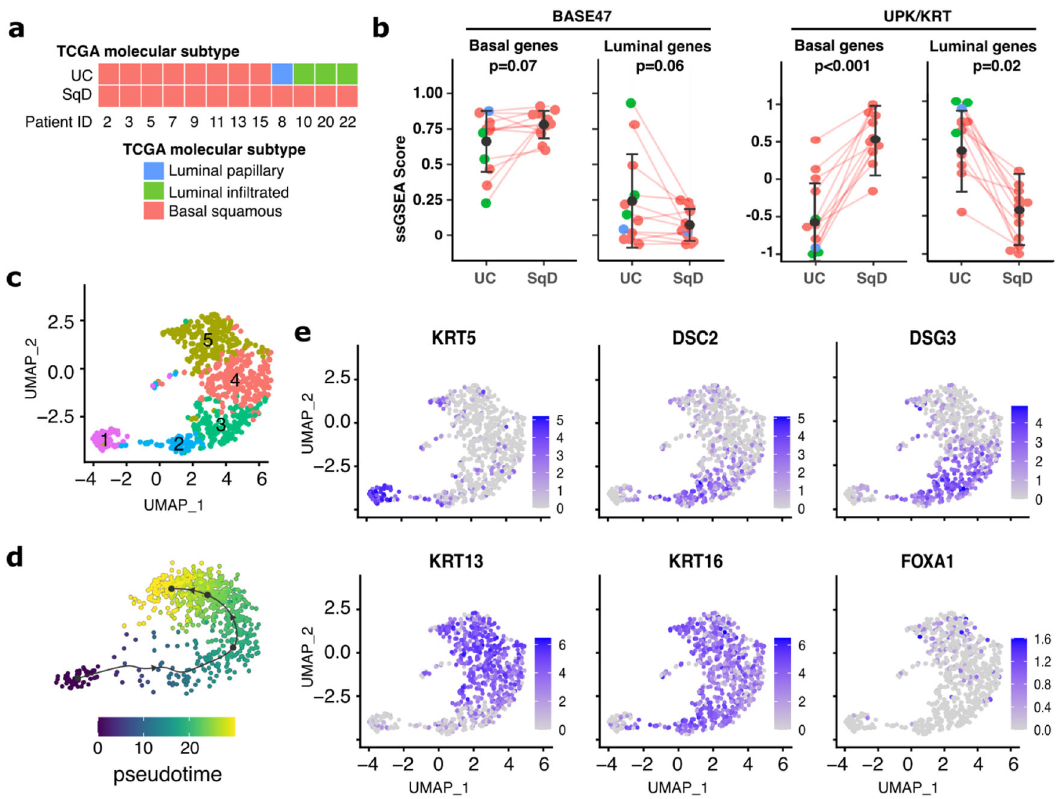
Fig. 2 | SqD and UC regions of mixed histology tumors have distinct gene expression pro fi les. a RNA sequencing analysis of 12 pairs of macrodissected UC and SqD regions from bladder tumors with mixed histology. Each region was classi fi ed using the TCGA molecular signature classi fi cation schema. All 12 SqD regions werebasal/squamous subtypeas were 8 ofthe 12 UCregions. Four tumors had discordant molecular subtypes. b Expression of BASE47 (left) and UPK/KRT (right) genes were evaluated by single sample GSEA analysis. Analysis was per- formedon12biologicallyindependentUC-SqDpairs,Errorbarsrepresentstandard error, p =0.0005, two-sided paired Wilcoxon rank sum test. c Single-cell RNA-Seq analysis of a bladder carcinoma with extensive squamous differentiation revealed fi ve clusters of tumor cells (clusters 1 – 5). d Trajectory analysis of these cell